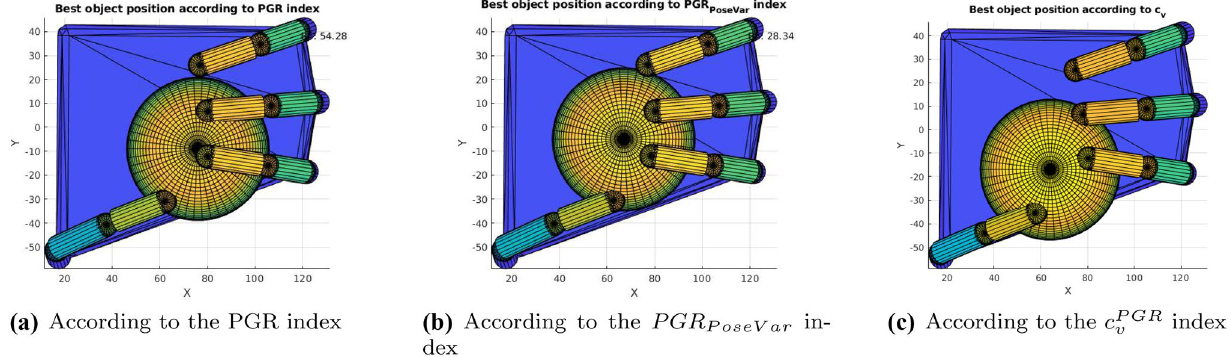
Fig. 13 The best power grasp for an 30mm radius